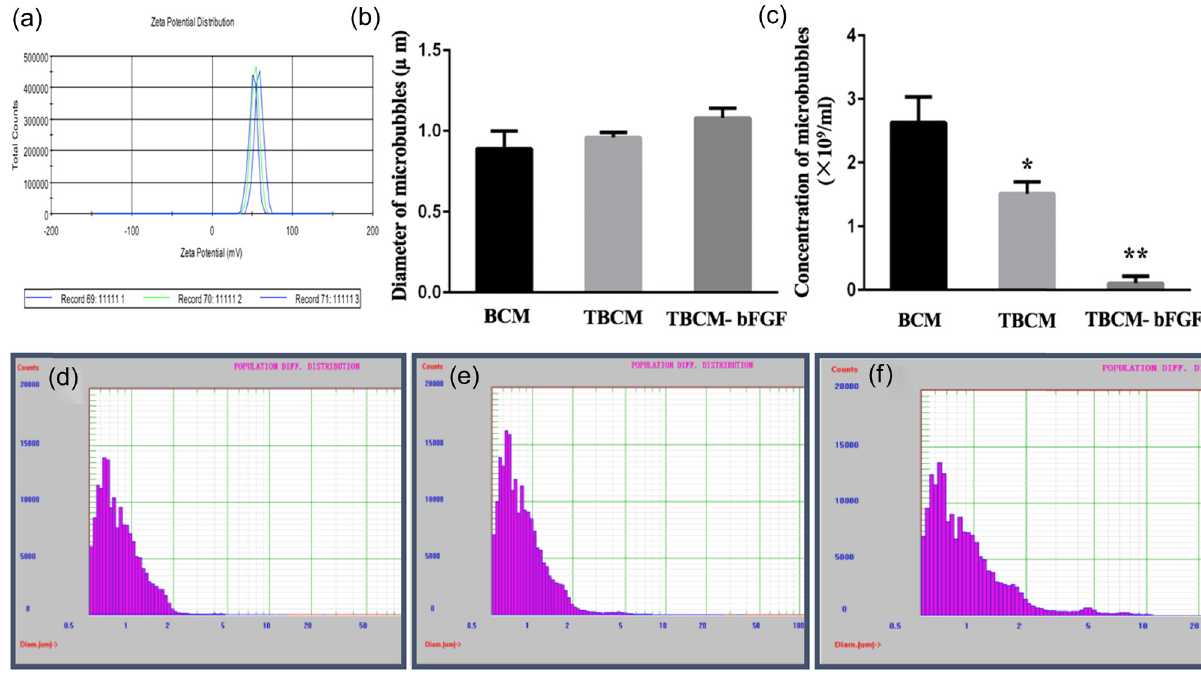
Figure 3: The concentrations and particle sizes of three kinds of microbubbles: ( a ) the surface charges of the cationic acoustic microbubbles; ( b ) the diameter of three kinds of microbubbles; ( c ) the concentrations of three kinds of microbubbles; ( d ) particle size distribution of BCMs; ( e ) particle size distribution of TBCMs; and ( f ) particle size distribution of TBCMs with the bFGF gene ( TBCM - bFGF ) .